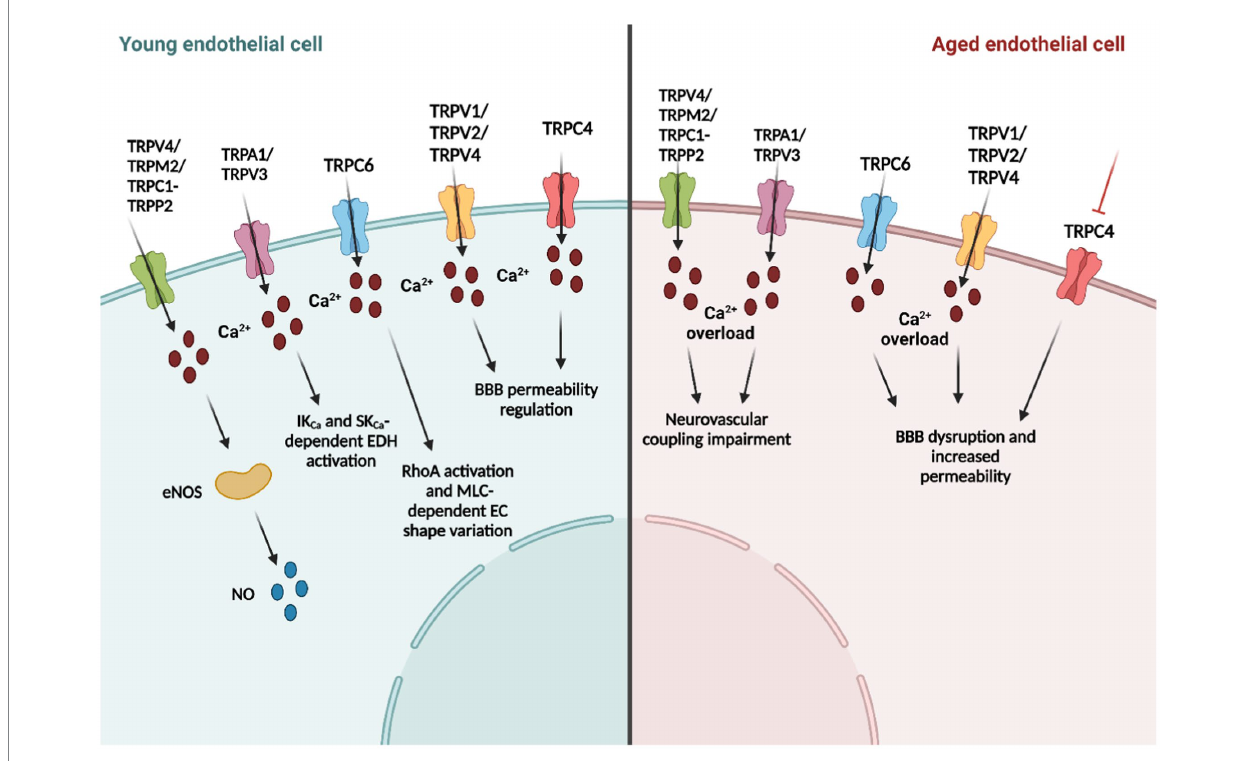
FIGURE 1 Age-related changes in endothelial transient receptor potential (TRP) channel